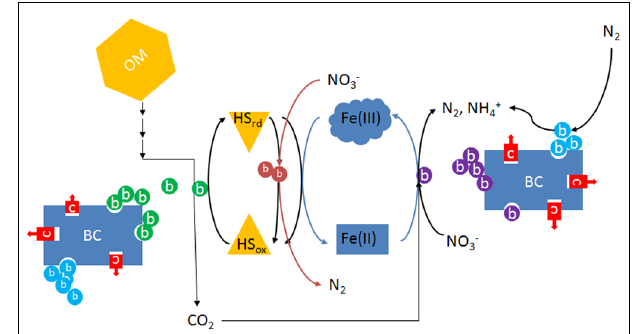
FIGURE 2 | Diagram illustrating the possible interactions between microbes, biochar, humic substances, and metals in water-saturated soil or sediments. Because of its abundance, only iron is considered here, although numerous metals may undergo similar processes. OM, organic matter; BC, biochar; HS rd , reduced humic substances; HS ox , oxidized humic substances; c (red), inorganic or organic contaminants such as heavy metals or pesticides; b (green), humics-reducing bacteria that may also be Fe-reducing; b (light red), nitrate-dependent humics-oxidizing bacteria; b (purple), chemolithoautotrophic nitrate-respiring iron-oxidizing bacteria; b (light blue), nitrogen-fixing